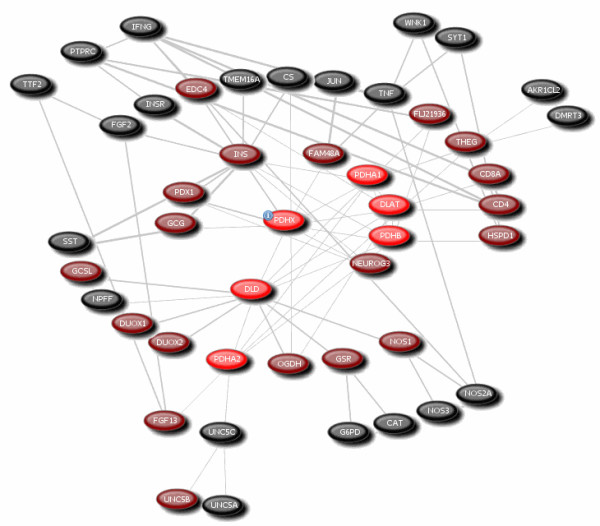
Pyruvate dehydrogenase component interacting genes. The systems biological approach showing the complex interaction of pyruvate dehydrogenase components (red) with 40 genes.